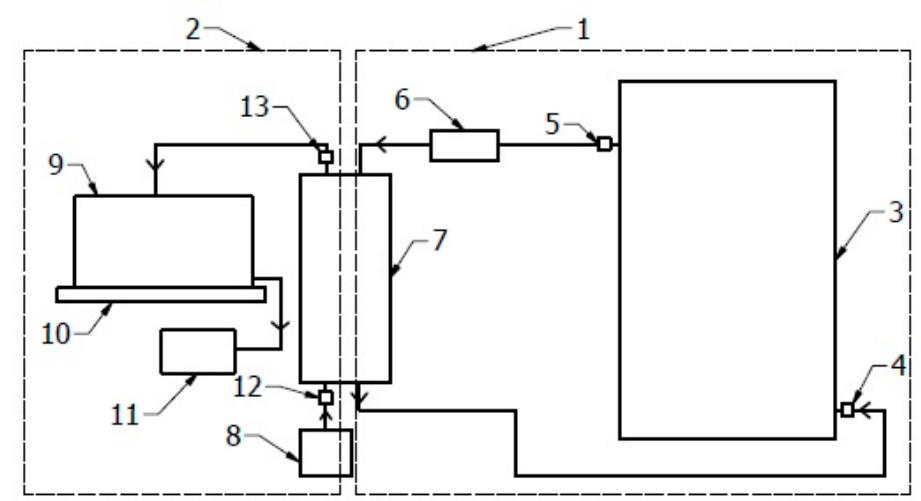
Figure 2. Scheme of a cooling system, 1—first circuit of water flow, 2—second circuit of water flow, 3—combustion chamber, 4—PT100 measurement point at inlet to test stand, 5—PT100 measurement point at outlet from test stand, 6—vane flow meter, 7—plate heat exchanger, 8—cold water supply, 9—bath, 10—scale, 11—hot water drain, 12—PT100 measurement point at inlet to the heat exchanger